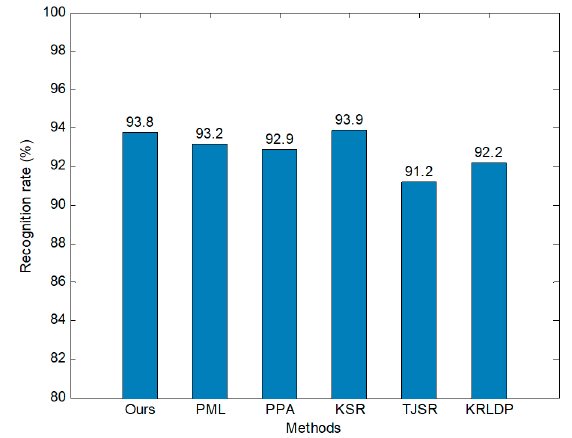
Figure 12. Comparison of different methods under the configuration test.